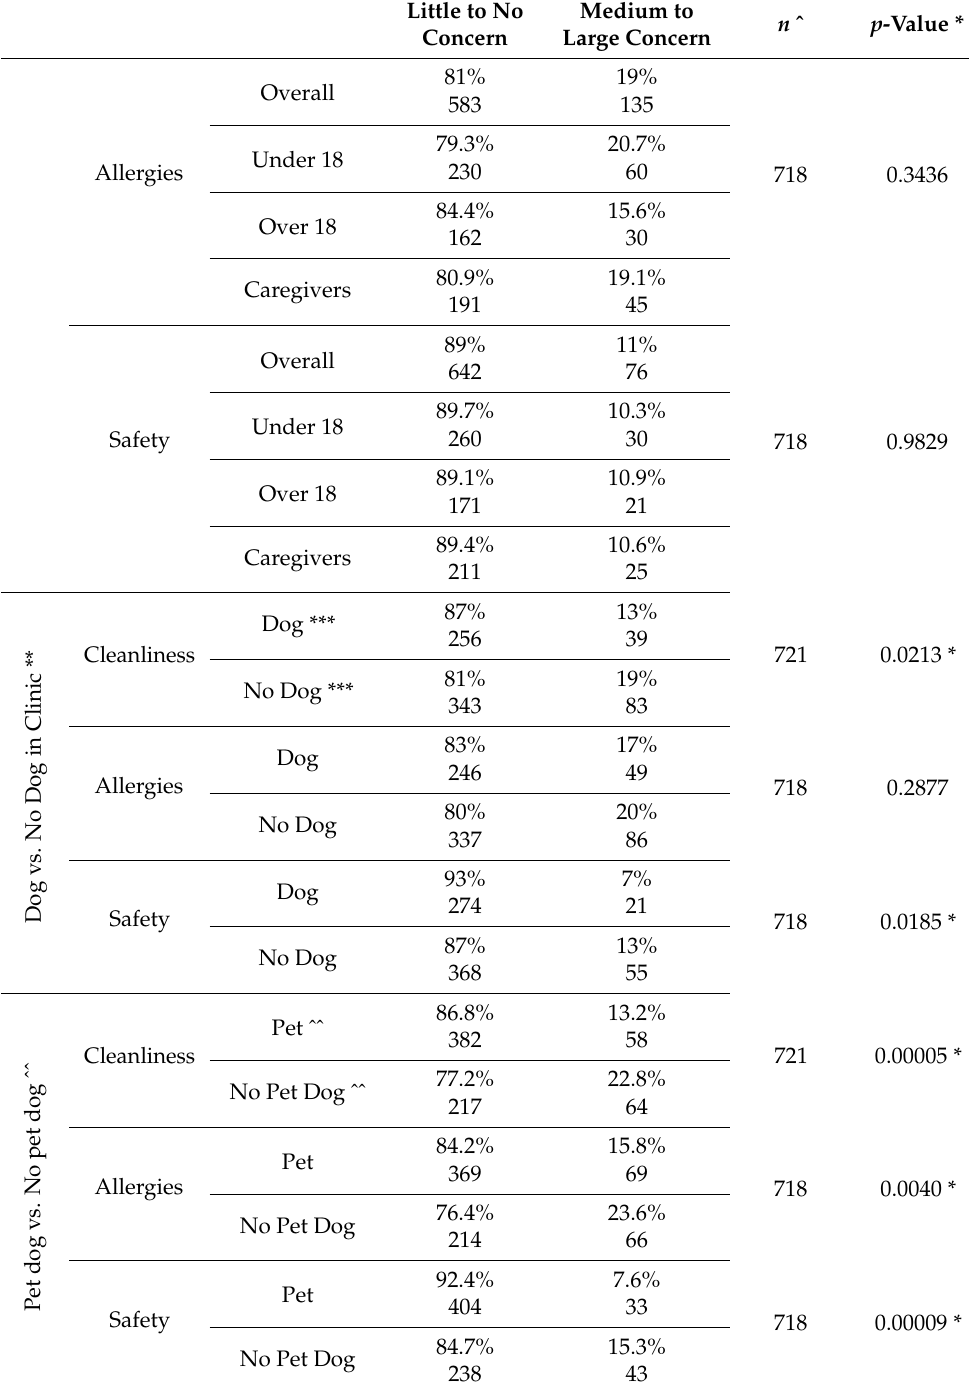
Table 2. Cont. When Thinking about a Therapy Dog in a Dental Setting, How Much Concern Would You Have for Each of the Following?